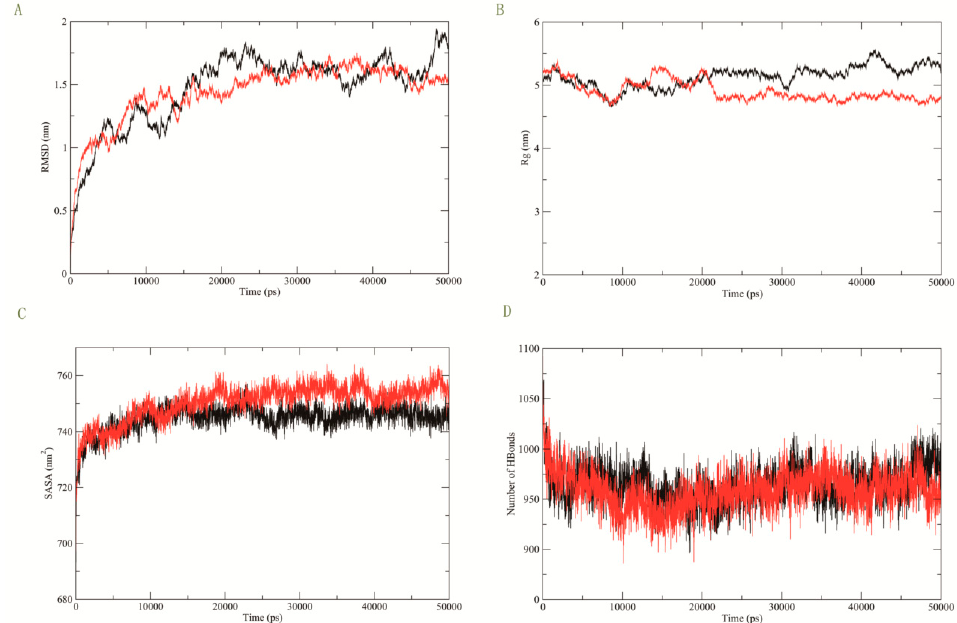
Figure 3. MD simulation results of BACE1-FLG and BACE1-FLG (Ser742Tyr) mutant. ( A ) The RMSD plot depicts that there are no erratic fluctuations in the molecular systems and all complexes are stable. ( B ) The result of the Rg elucidates the volumetric and compactness variations induced in the complex. ( C ) The result of SASA for the protein structures with dimensional discrepancy. ( D ) The hydrogen bonds reflect the protein’s rigidity and its ability to interact with its partners.)